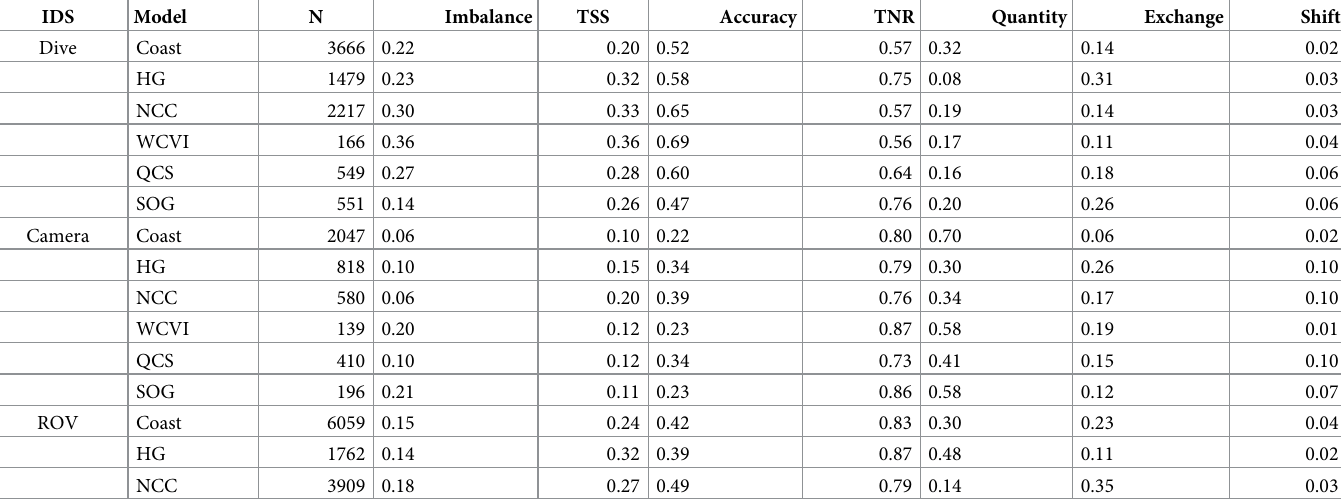
Table 4. Performance of each random forest model against each independent data set (IDS) (see Table 3 for description of metrics).